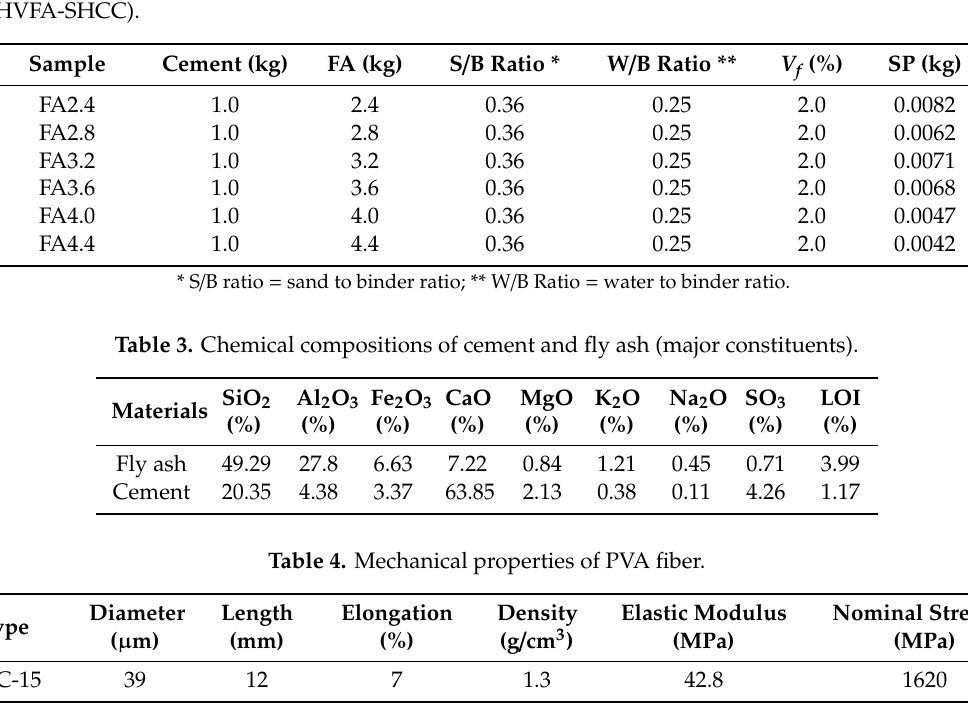
Figure 3. E ff ect of fly ash (FA) to cement ratio and sand to binder ratio on the standard deviation between the designed PSD curve and the optimal grading curve. ( a ) E ff ect of FA to cement ratio; ( b ) e ff ect of sand to binder ratio.